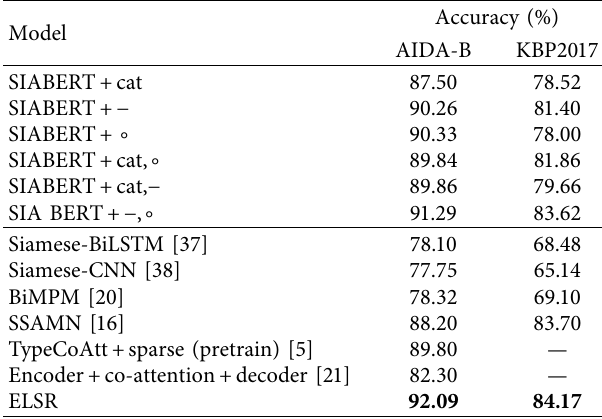
Table 3: The accuracy results of all methods on the 2 public